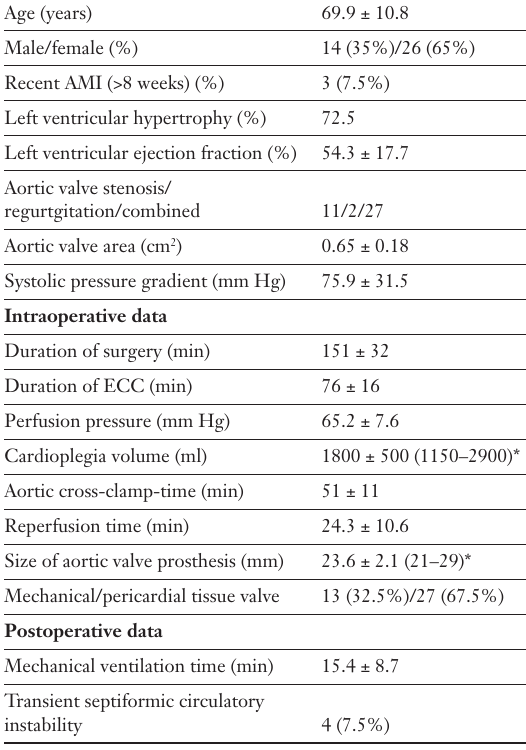
Preoperative demo- graphic data and in- traoperative data for all 40 patients in- cluded in the study (mean ± SD); * mean (min–max).